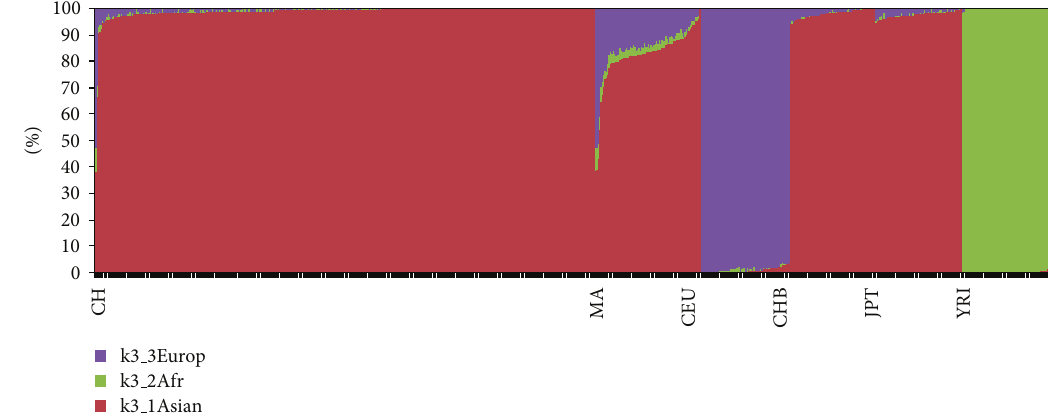
Figure 2: Admixture proportions of Chinese and Malays. Malaysian Chinese had less evidence of admixture from Europeans and Africans than Malaysian Malays (CH: Malaysian Chinese; MA: Malaysian Malays; CEU: North Europeans from CEPH; CHB: Beijing Chinese; JPT: Japanese; YRI: Yorubans from